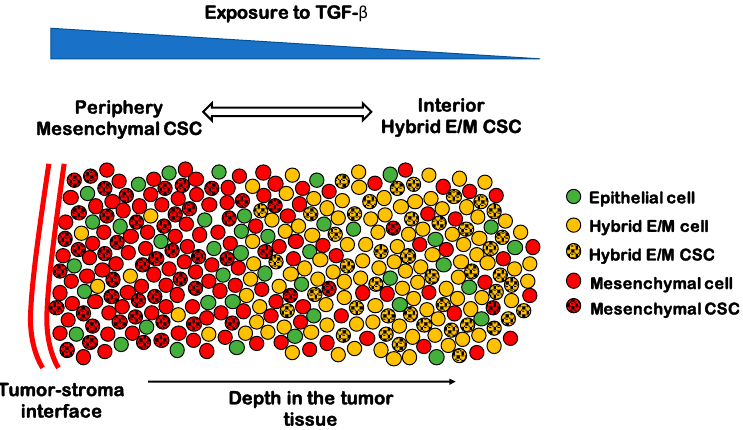
Figure 5. The spatial patterning of CSCs with different EMT phenotypes. Tumor-stroma interactions can give rise to a gradient of TGF- β (top, blue scale). In the periphery of the tumor, most cells are mesenchymal (red spheres), while the interior is mostly composed by hybrid E/M and epithelial cells (yellow and green spheres, respectively). CSCs are mostly mesenchymal in the periphery (black-dotted red spheres) and mostly hybrid E/M in the interior (black-dotted yellow spheres).